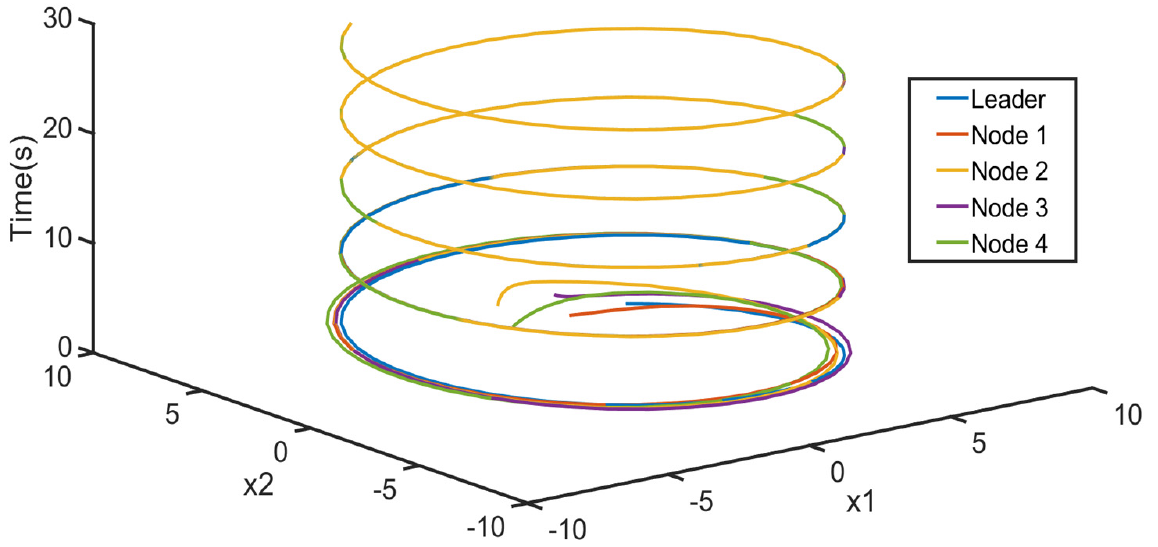
Figure 3. The 3-D phase plane plot of the system’s evolution for agents 1, 2, 3, 4 and leader 0.